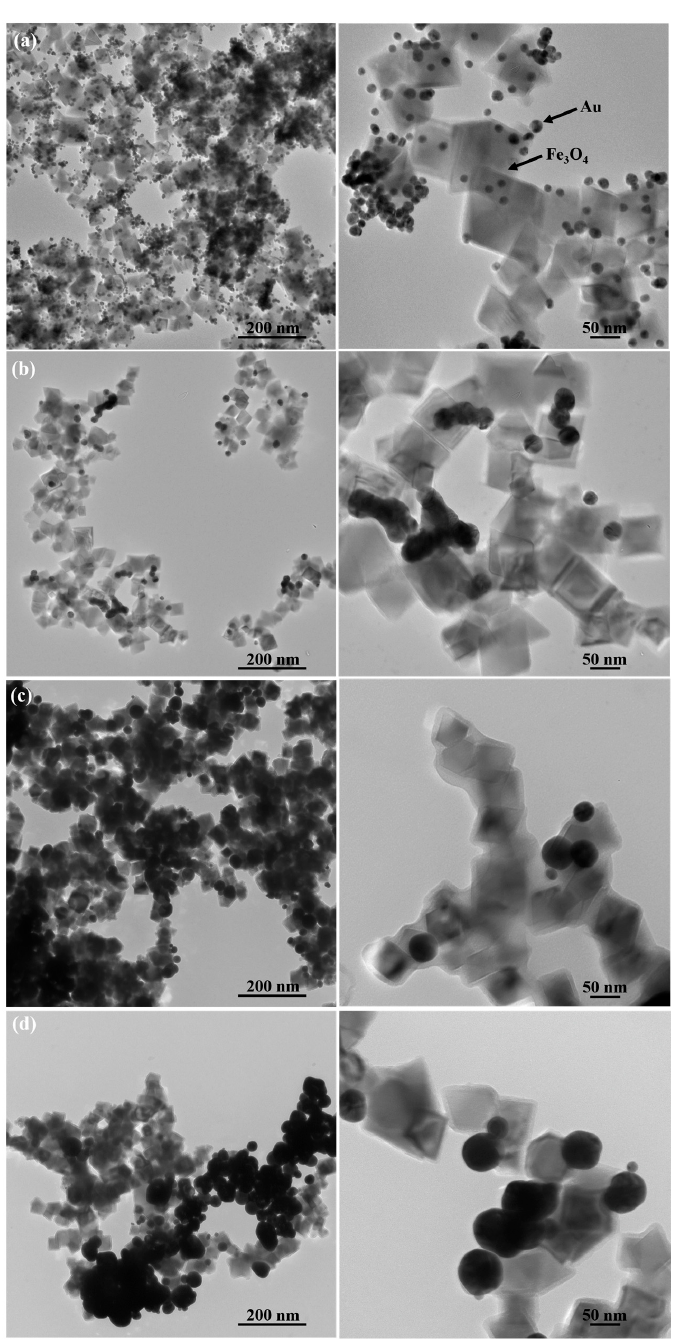
Figure 2. TEM images of surface modified MNP (magnetite nanoparticles) decorated with Au nanospheres of distinct average sizes: ( a ) MNP-Au(15); ( b ) MNP-Au(37); ( c ) MNP-Au(71); ( d ) MNP-Au(102).